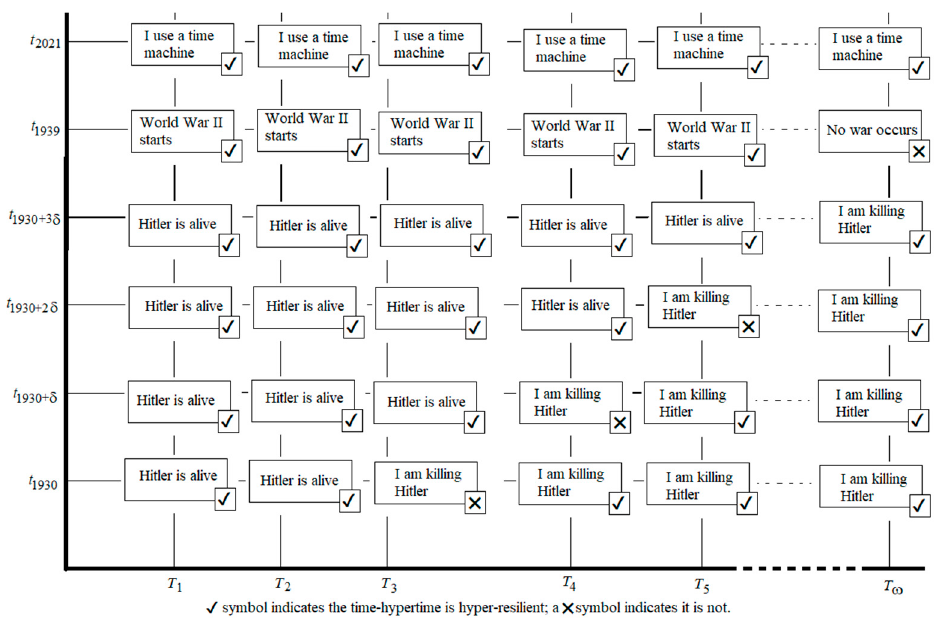
Figure 3. A globally propagative time travel scenario.